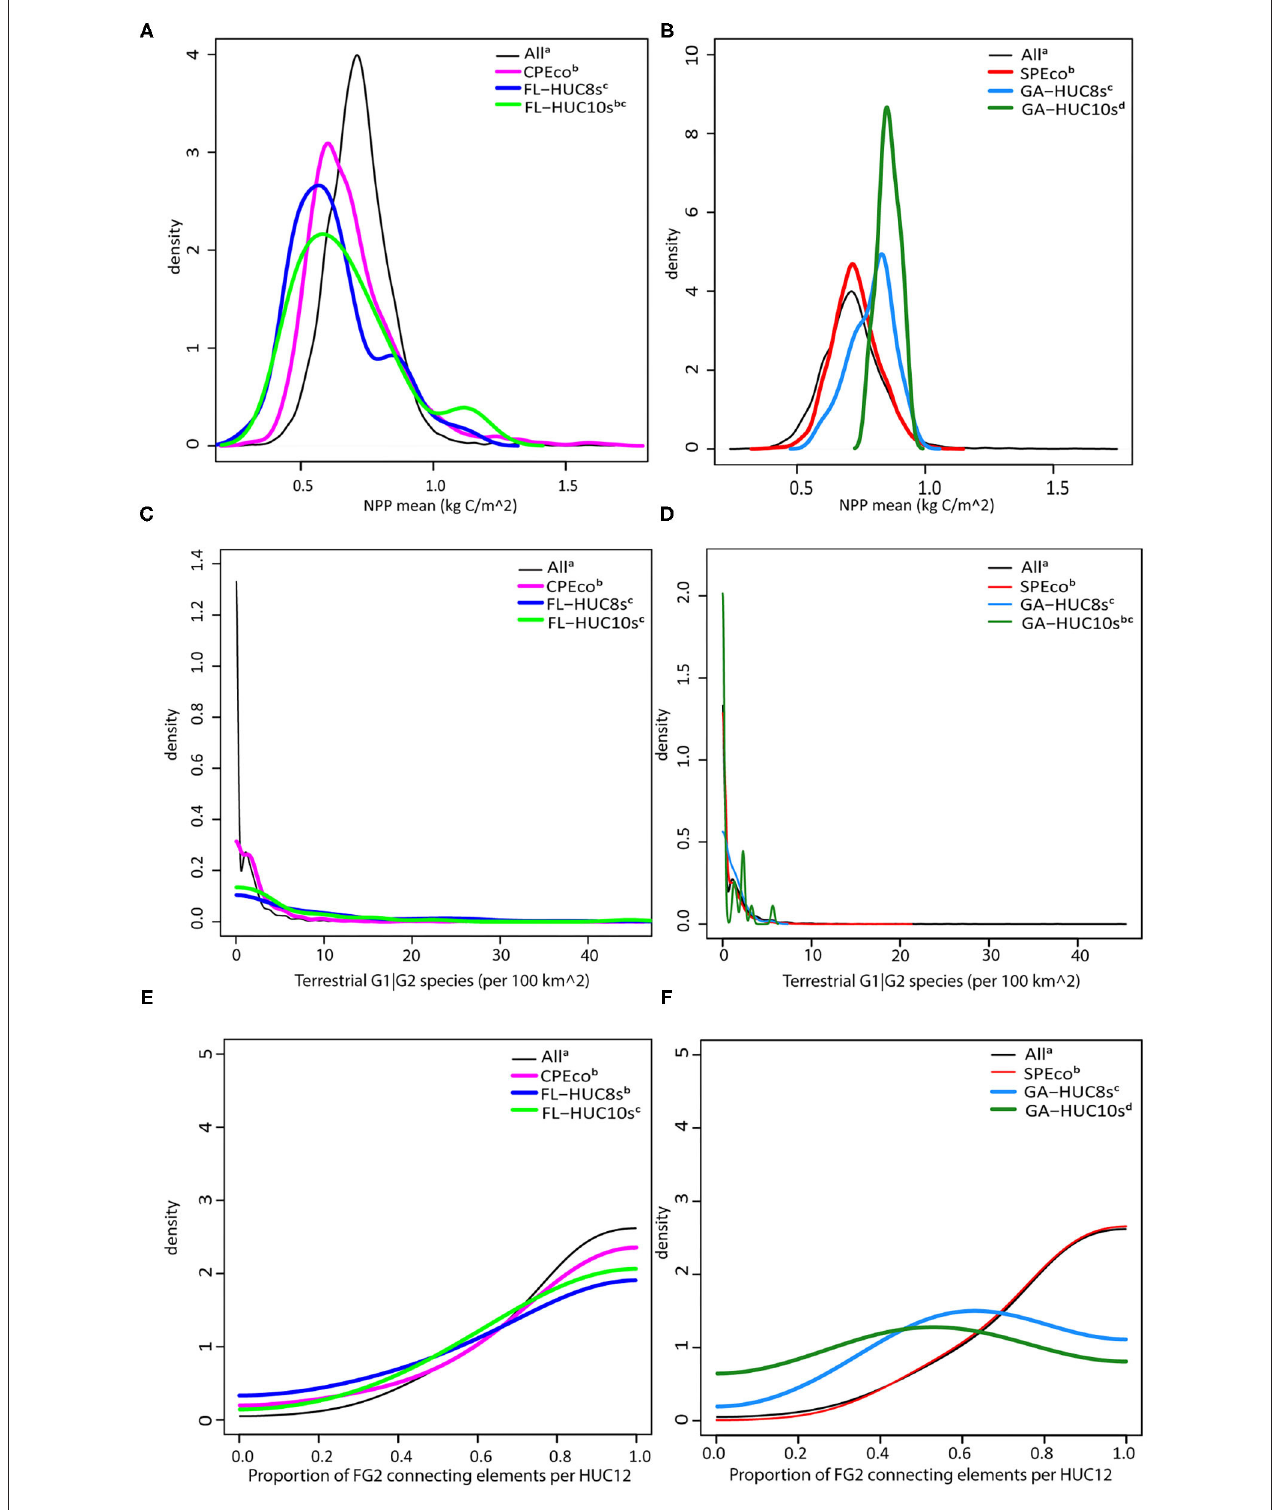
FIGURE 11 | Kernel density function comparisons where superscripts indicate similar distributions (Anderson-Darling statistic P > 0.05; Supplementary Material 4 ). (A) Mean NPP (kg C/m 2 )—all data with Florida sub-regions. (B) Mean NPP (kg C/m 2 )—all data with Georgia sub-regions. (C) Terrestrial Imperiled Species (n/100 km 2 )—all data with Florida sub-regions. (D) Terrestrial Imperiled Species (n/100 km 2 )—all data with Georgia sub-regions. (E) Proportion of FG2 connecting elements—all data with Florida sub-regions. (F) Proportion of FG2 connecting elements—all data with Georgia sub-regions.